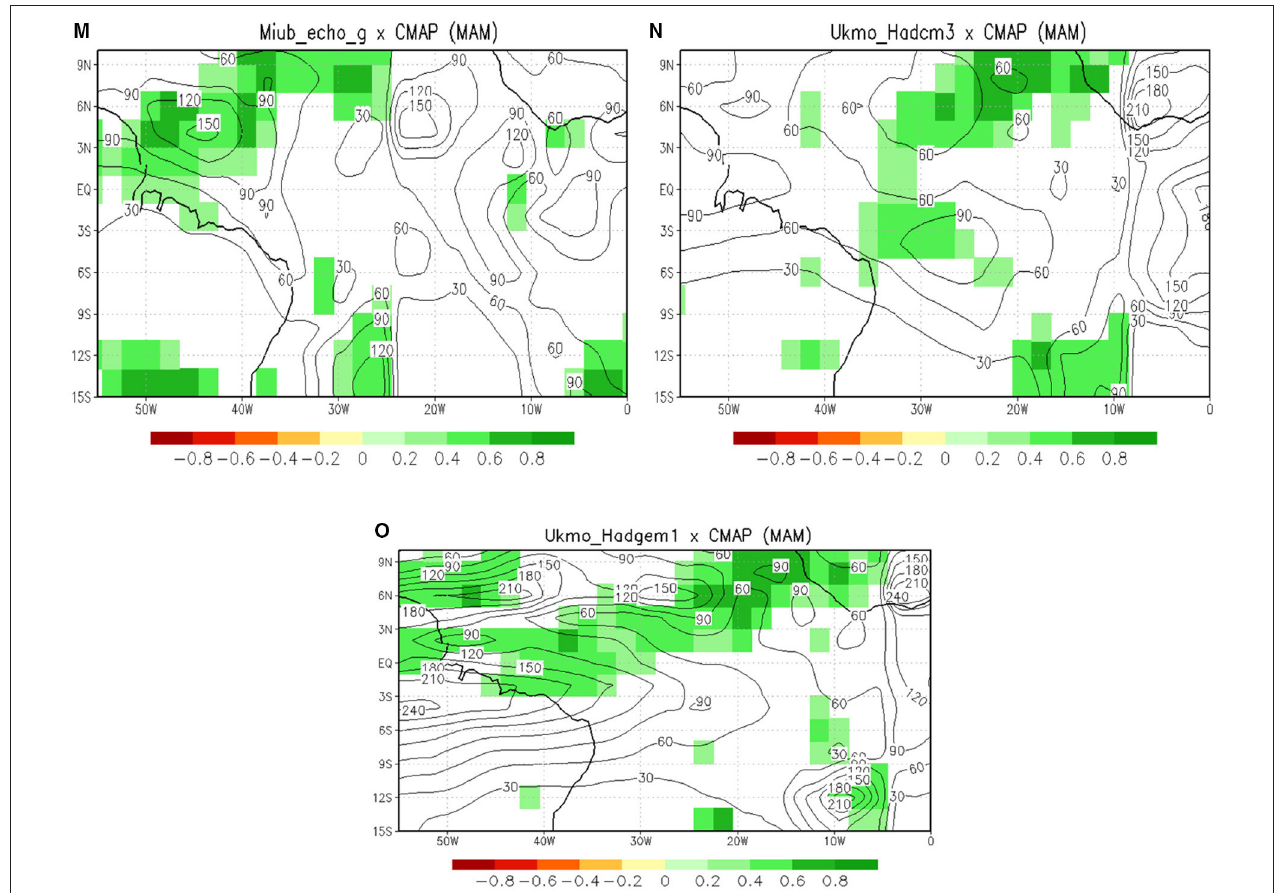
FIGURE 7 | Correlation (shaded) and absolute error (contour in mm/day) to austral autumn (MAM) between observation (CMAP) and simulations from the CMIP3-AR4 models for period 1979–2000. The models considered are: (A) Bccr_ccm2_0, (B) Ccma_cgcm3_1_T63, (C) Cnrm_cm3, (D) Csiro_mk3_5, (E) Gfdl_cm2_0, (F) Gfdl_cm2_1, (G) Giss_m_e_r, (H) Iap_goals_1_0_g, (I) Ingv_Echam4, (J) Inmcm3_0, (K) Ipsl_cm4, (L) Miroc3_2_medres, (M) Miub_echo_g, (N) Ukmo_hadcm3, and (O) Ukmo_Hadgem1. Green areas indicate statistical significance of the correlation at 95% according to the Student’s t